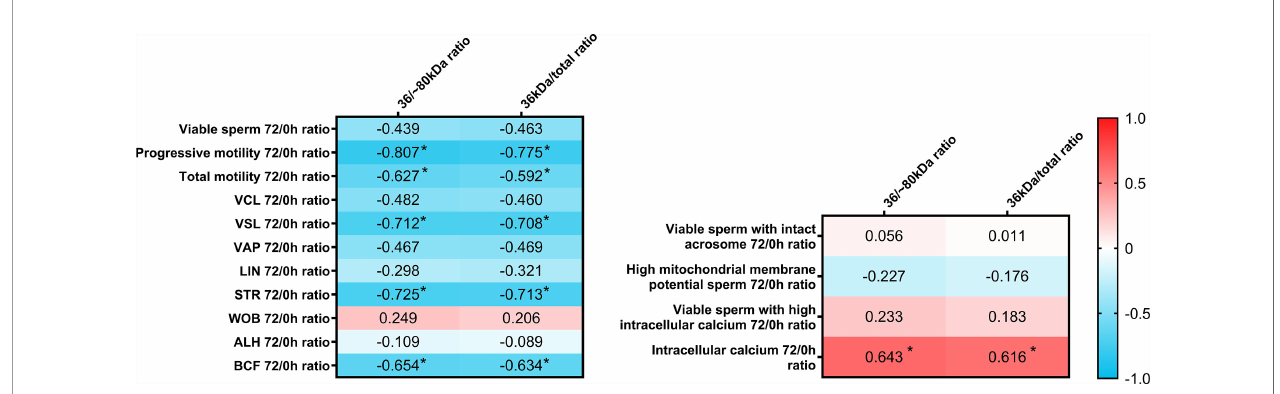
FIGURE 4 | Correlation plot of sperm quality and functionality parameters (including sperm morphology, motility, viability, acrosome integrity, mitochondrial membrane potential and intracellular calcium) 72/0 h ratios and 36/~80 kDa and 36 kDa/total ratios. Semen samples of 16 AI-boars (one ejaculate per boar) were evaluated immediately after semen samples arrived at the laboratory (0 h) and after storage/preservation at 17°C for 72 h, and the ratio72/0h was calculated for each. The color saturation of red to blue represents the correlation coef fi cients (R) from 1 to -1, respectively. Signi fi cant correlations ( P < 0.05) are marked with